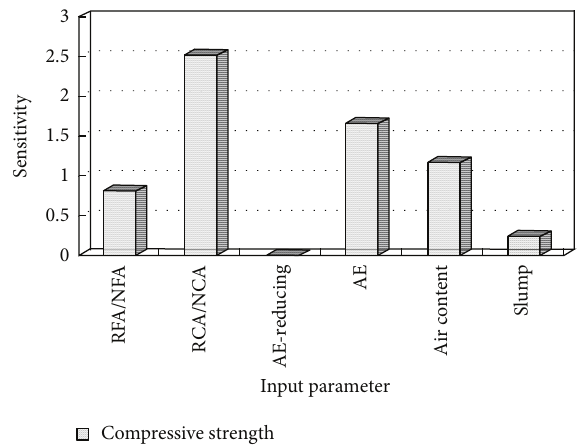
Figure 6: Sensitivity about the mean showing the dependence on the input